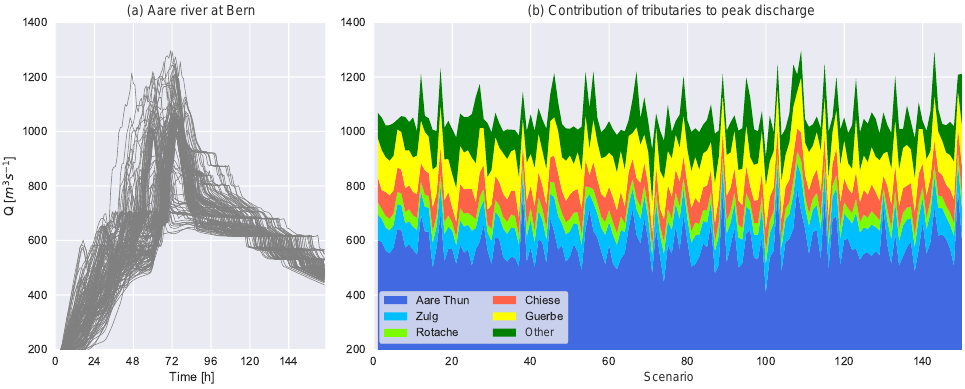
Figure 3. (a) Hydrographs at the outlet of the Aare River basin in Bern resulting from the coupled hydrologic-hydrodynamic modelling of the 150 PMP scenarios. (b) Superimposition of the tributaries downstream of Lake Thun during peak flow of the Aare River at Bern.